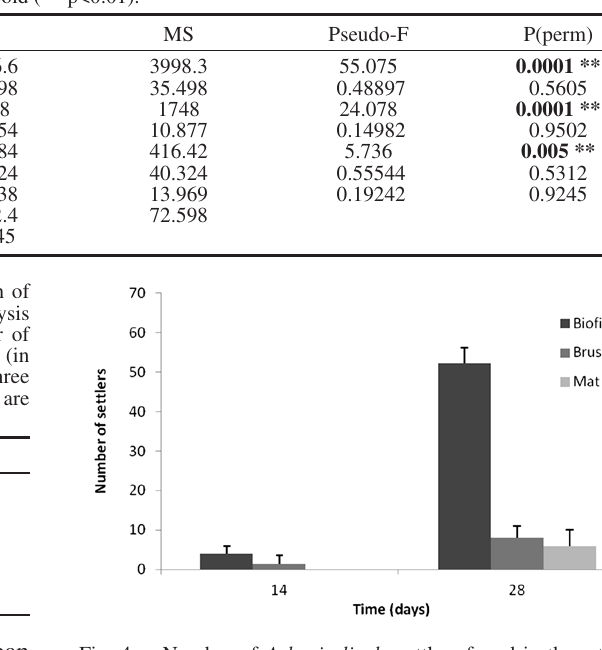
Fig. 4. – Number of Arbacia lixula settlers found in the artificial collectors deployed in Abades in February 2012. Error bars show standard